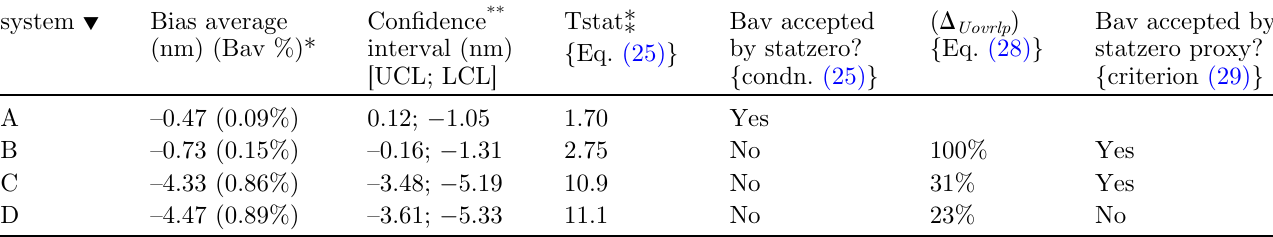
Table 4. Example 3 results (FAC-1, 4 systems). system